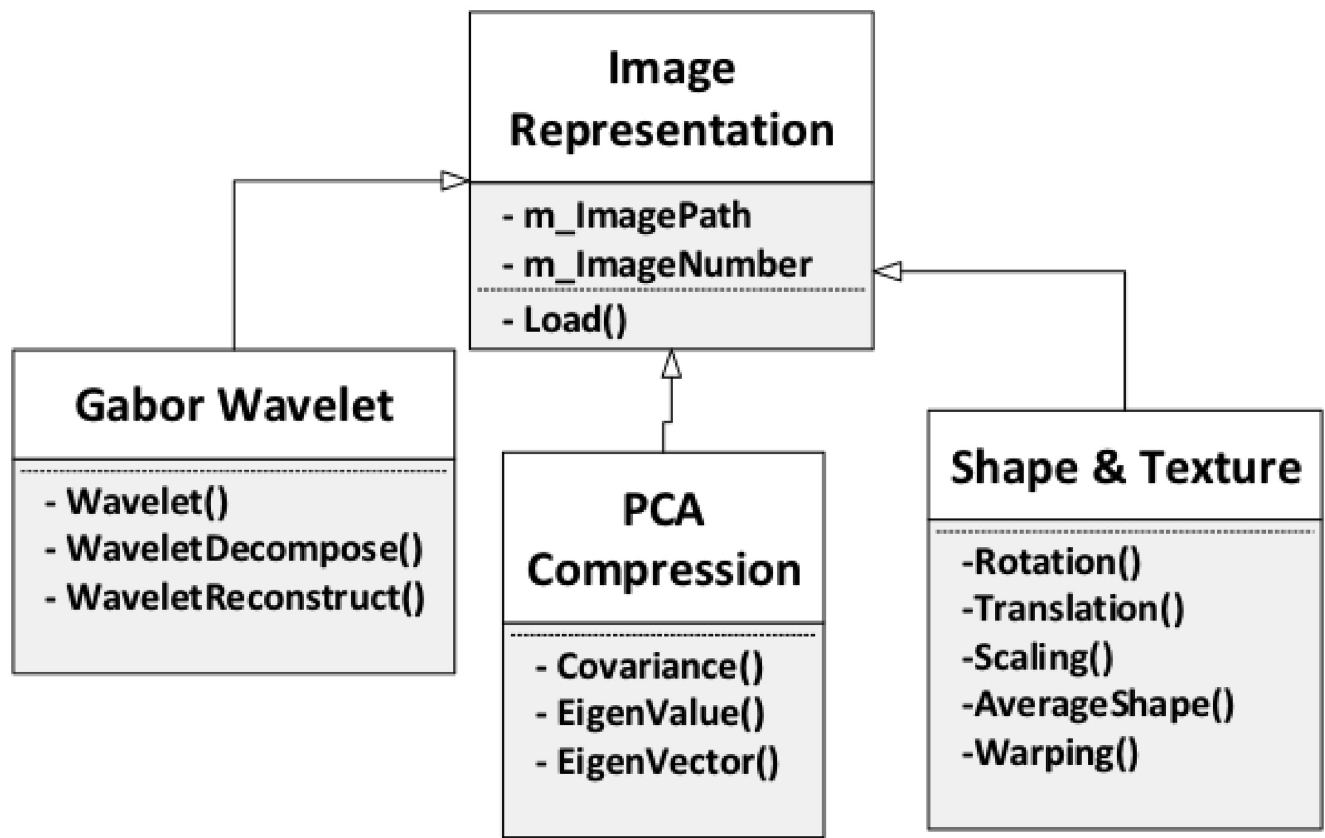
Fig 9. Image representation.